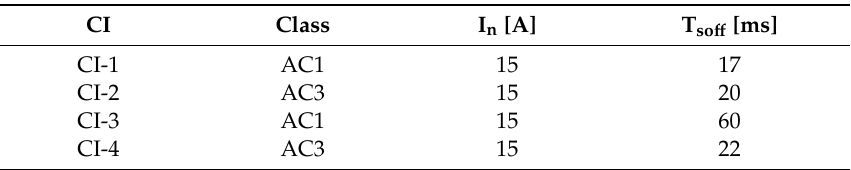
Table 1. Tested objects selected